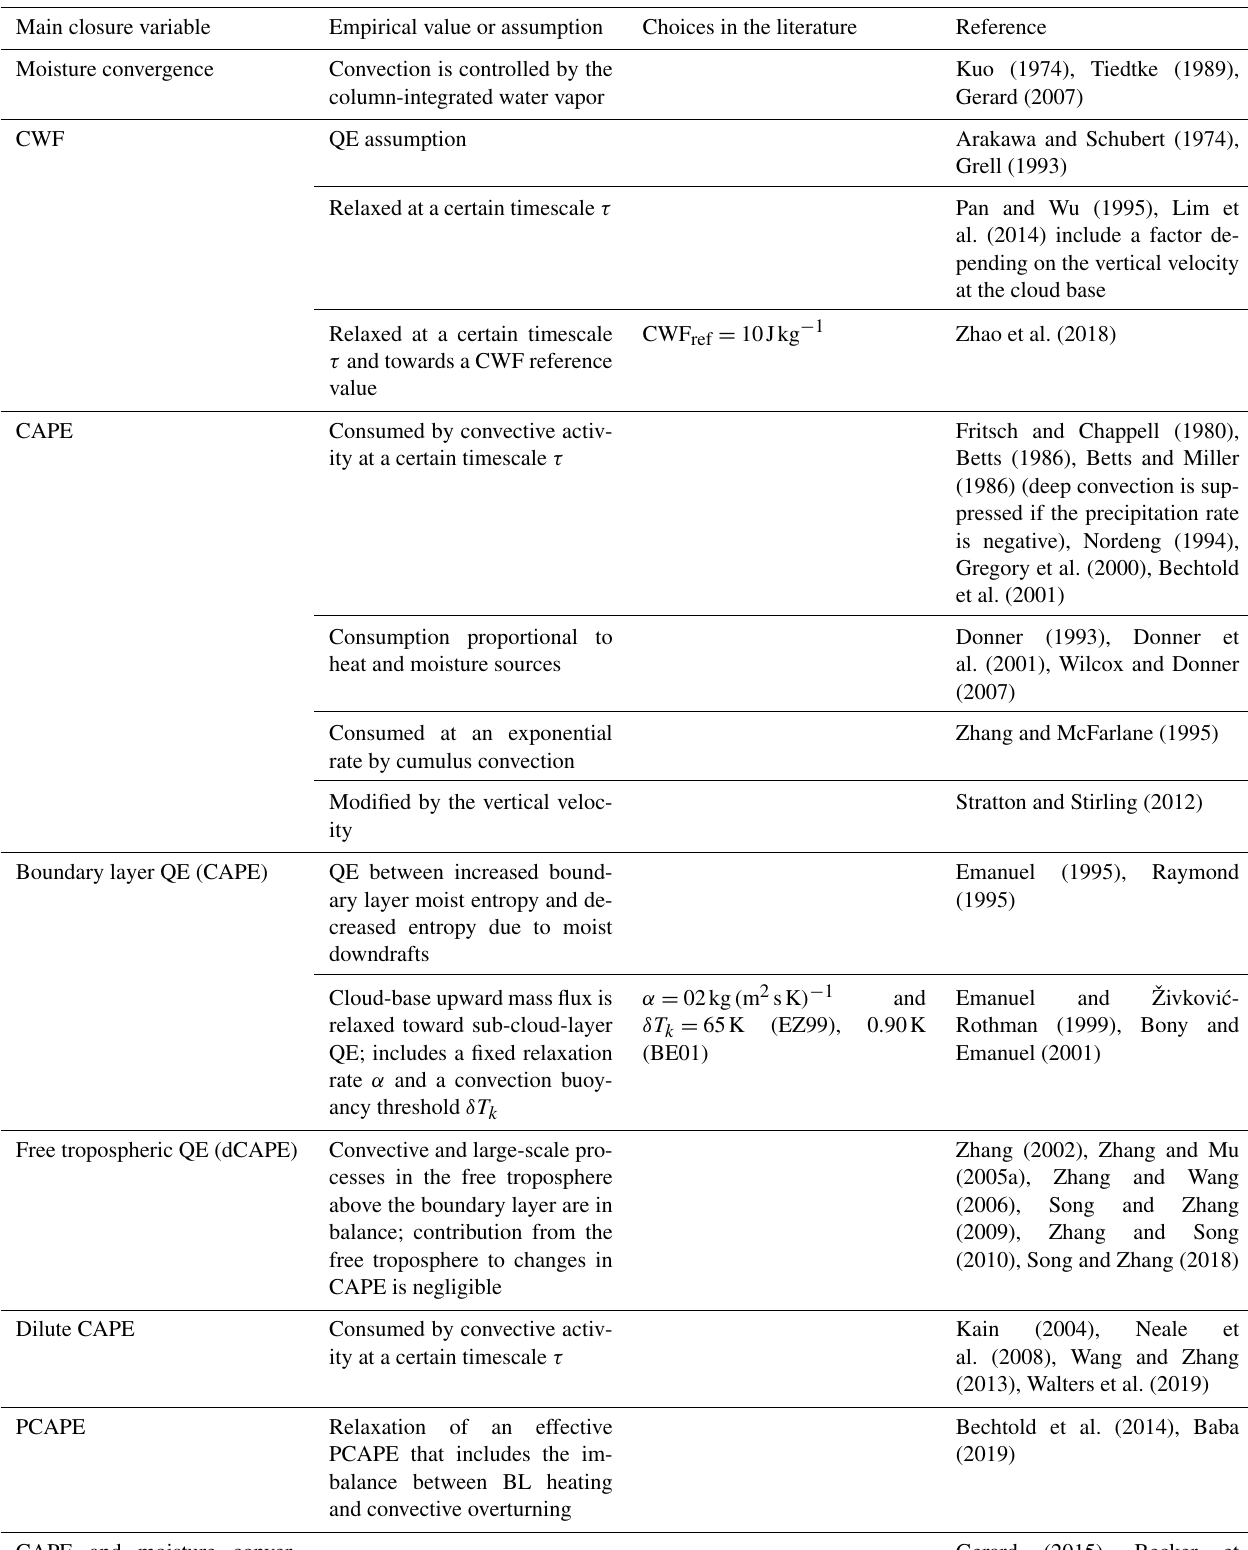
Table 12. A sample of empirical values and assumptions used in the closure in the